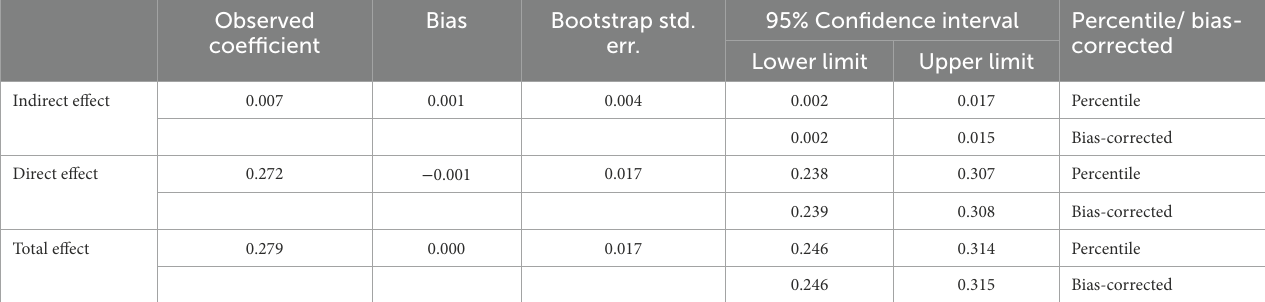
TABLE 5 Results of the test for mediating effects based on Bootstrap method.